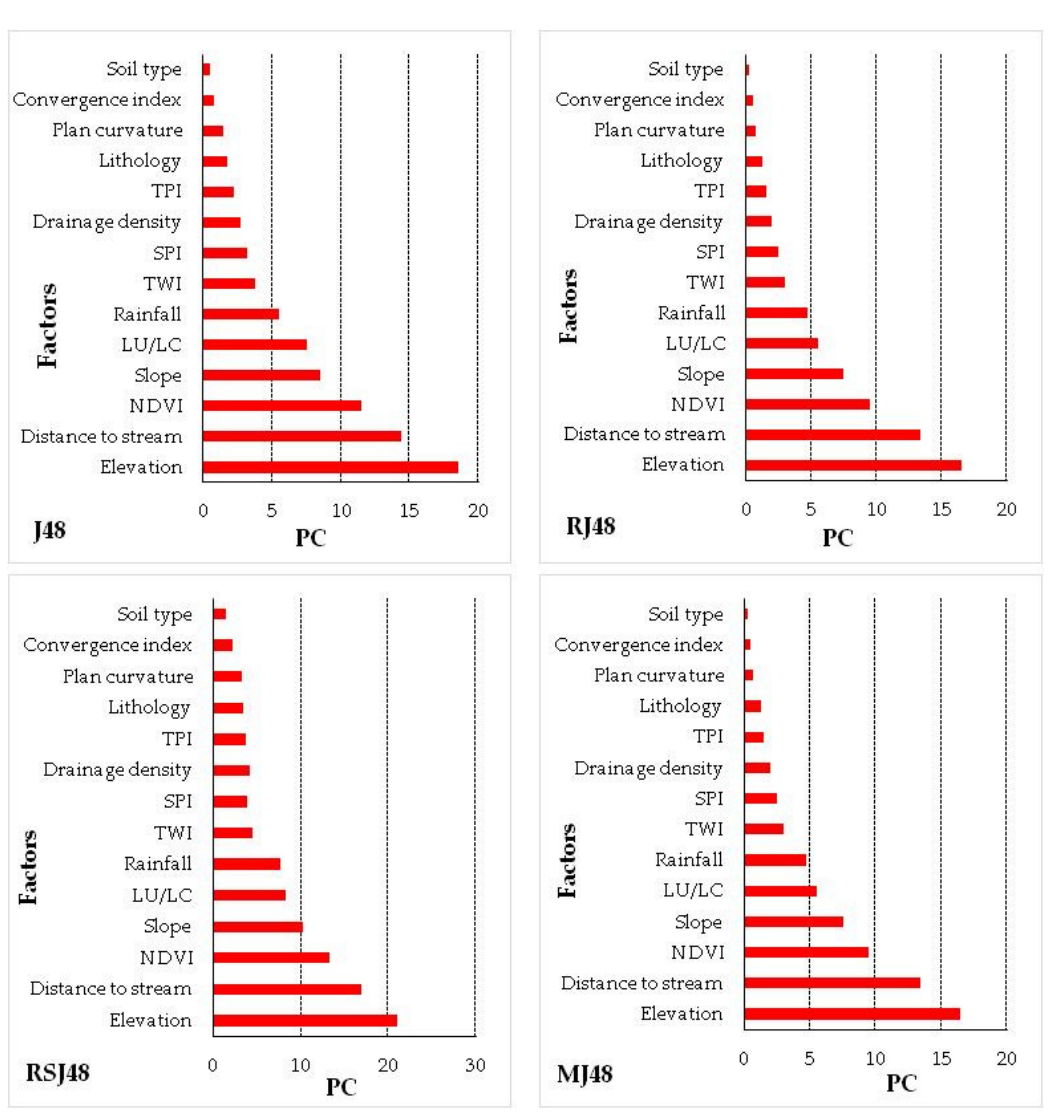
Figure 9. Sensitivity analysis results from the percentage of contribution (PC) of each flood conditioning factor (FCF) in different models.